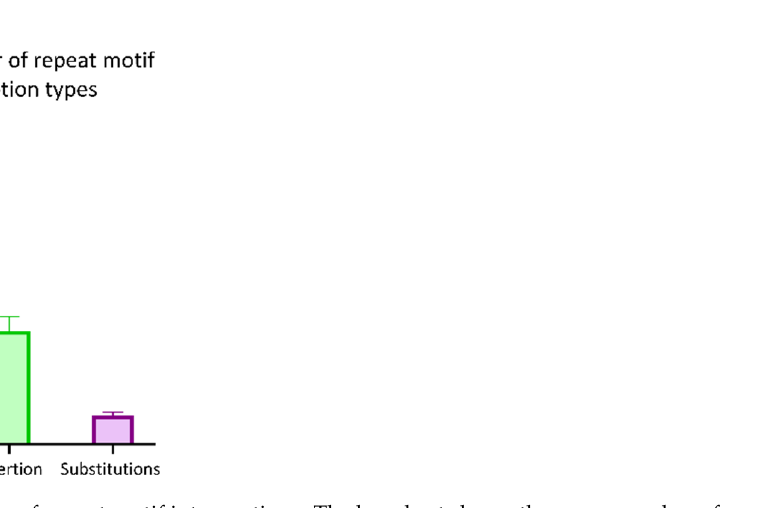
Figure 2. Occurrence of repeat motif interruptions. The bar chart shows the mean number of repeat motif interruptions per patient sample, stratified by type (i.e., deletion, insertion, substitution). The bars and whiskers represent the mean and upper limit of the standard deviation.